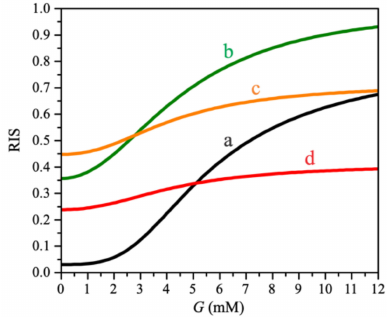
Figure 6. Influence of individual factors on glucose-dependent relative insulin secretion (RIS). ( a ) Absence of FFAs ( f FFA = 0, k p,leak = 0, k md = 0). A response of a healthy beta cell under